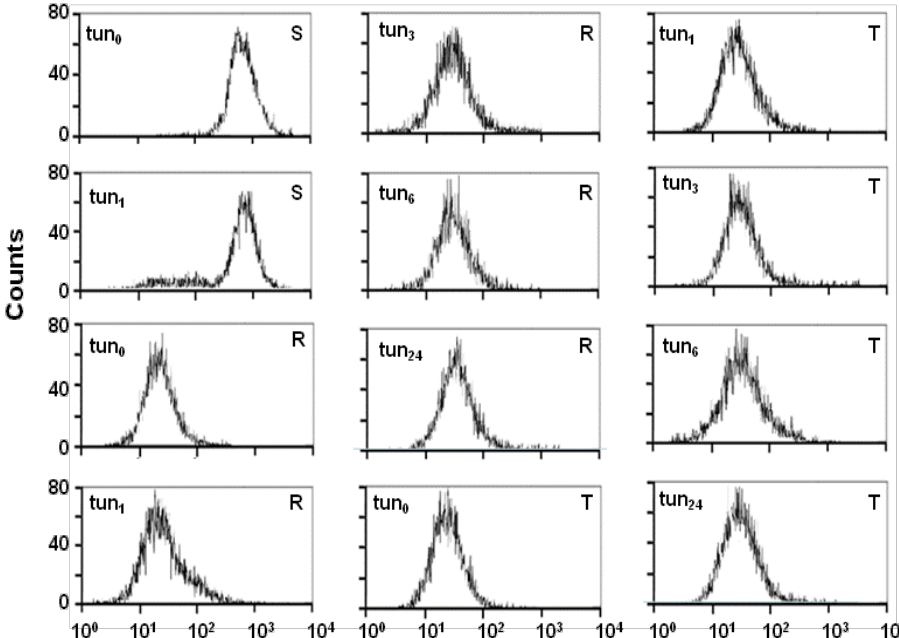
Figure 5. Calcein/AM retention assay of the influence of tunicamycin on P-gp transport function. Cells (S, R and T) were cultivated in the absence (tun (tun ), three (tun ), six (tun ) or twenty-four passages (tun 1 3 6 treatment, and then the calcium/AM assay was performed. These data are representative of three independent